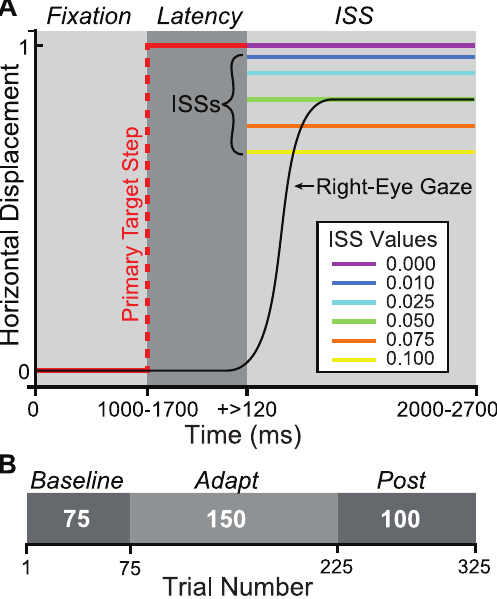
Figure 1. Methods. A. Single-Trial Temporal & Spatial Structure. Red: pre-saccade target; black: right-eye gaze; violet: 0.0 (no) ISS; blue: 0.01; light blue: 0.025; green: 0.05; orange: 0.075; yellow: 0.1. ISSs and primary target step are not drawn to scale. Gray scale boxes and italic text above indicate trial temporal windows. Fixation: pre-target-step fixation period; Latency: delay (ms) between primary target step and primary saccade onset; ISS: intrasaccadic target step and subsequent corrective saccade period. B. Experimental session phase structure. Phases are depicted as gray scale boxes with phase names above (italic). White numerals in each box indicate phase-length in trials. Absolute trial number is indicated on the axis.